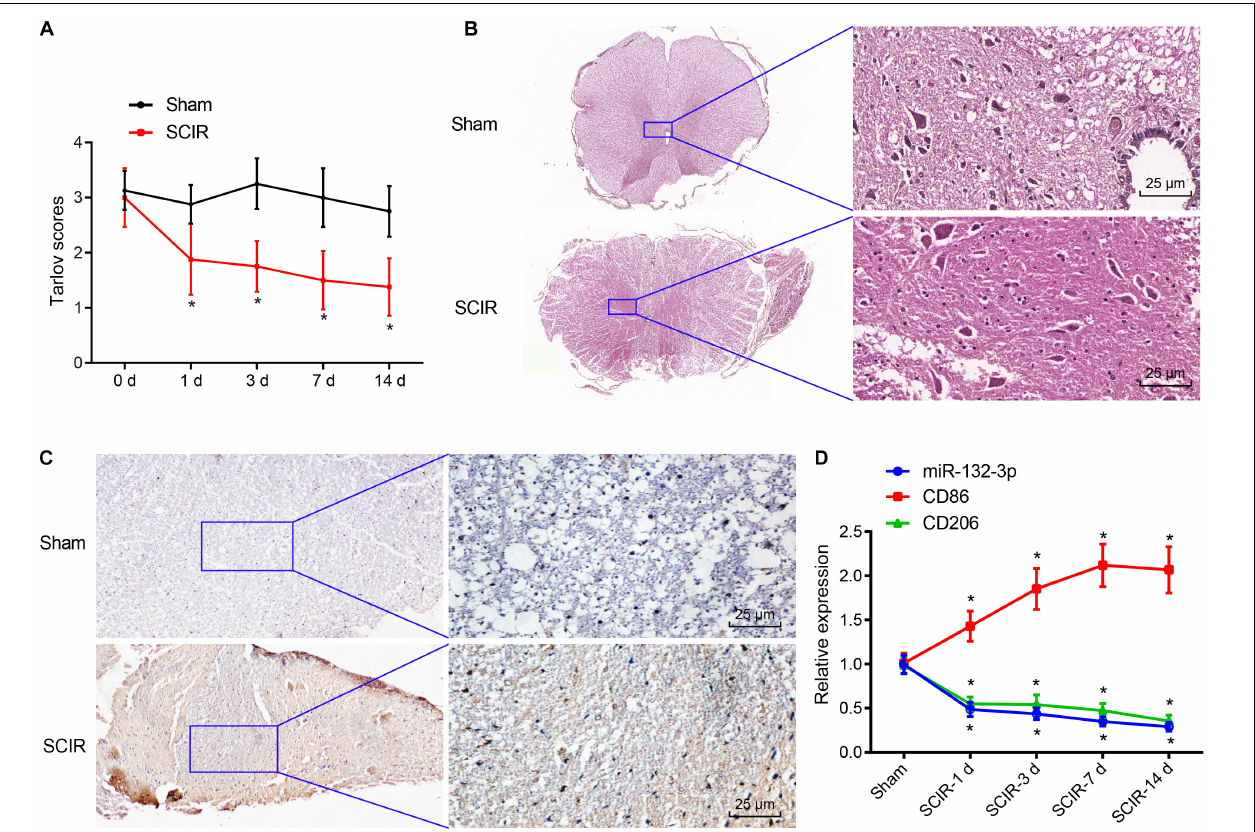
FIGURE 1 | Spinal cord tissues of SCIR injury rats exhibit low expression of miR-132-3p. (A) Tarlov score of SCIR injury rats and sham-operated rats. (B) Pathological features of spinal cord neurons in spinal cord tissues of SCIR injury rats and sham-operated rats observed by HE staining. (C) Expression of CD68 (a macrophage marker) in spinal cord tissues of SCIR injury rats and sham-operated rats detected by immunohistochemistry. (D) Expression of miR-132-3p, CD206, and CD86 in spinal cord tissues of SCIR injury rats and sham-operated rats measured by RT-qPCR. * p < 0.05 vs. sham-operated rats. Measurement data were expressed as mean ± standard deviation. n = 8 for rats following each treatment. Comparisons of data in panel (A) were conducted by repeated measures ANOVA and those in panel (D) were conducted by one-way